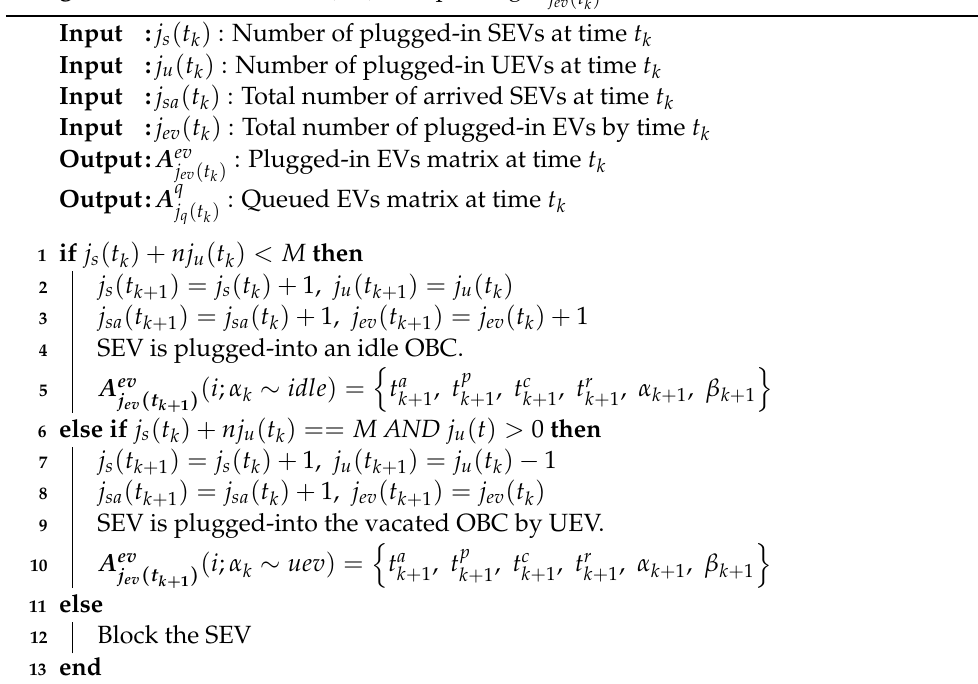
at SEV j ev ( t k )